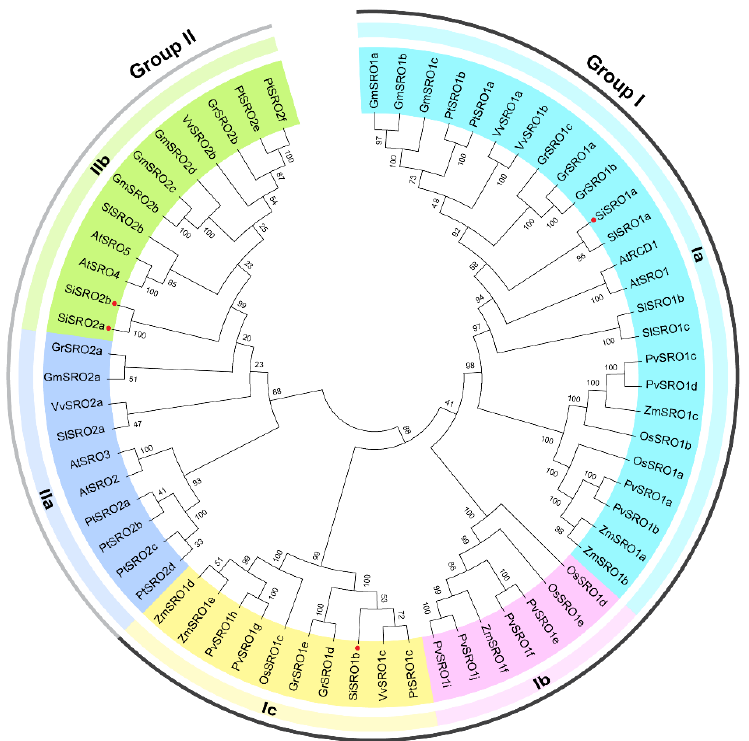
Figure 1. Phylogenetic analysis of SRO proteins from sesame and other plant species. The amino acid sequences of 64 SROs from sesame and other plant species were used to construct the phylo- genetic tree based on the NJ method with 1000 bootstrap replicates in MEGA 5.0. The red dots represent SROs in sesame. The detailed information of SROs from representative plant species used in phylogenetic tree constructed were listed in Table S1.